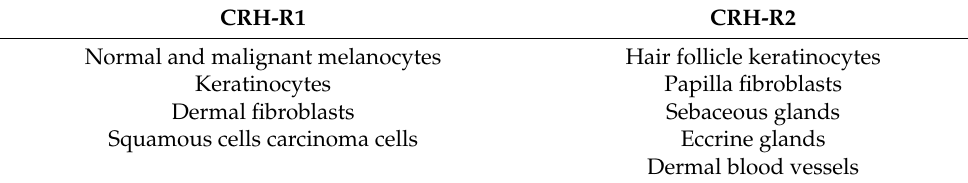
Table 2. The presence of CRH receptors in normal and diseased